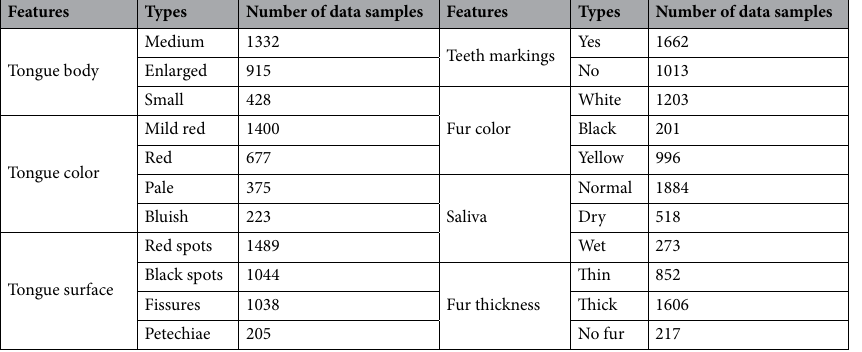
Table 1. Features associated with patient